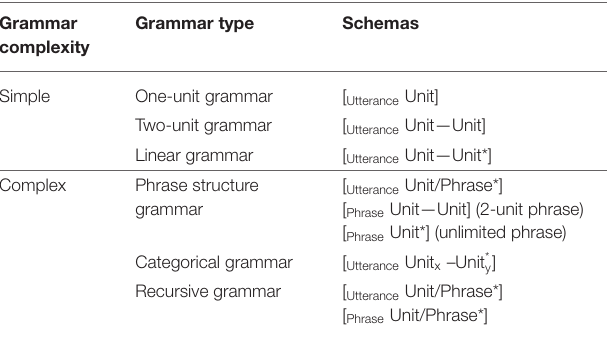
TABLE 1 | A hierarchy of grammars by Jackendoff and Wittenberg (2014), with modified terminology to apply across modalities. Grammar